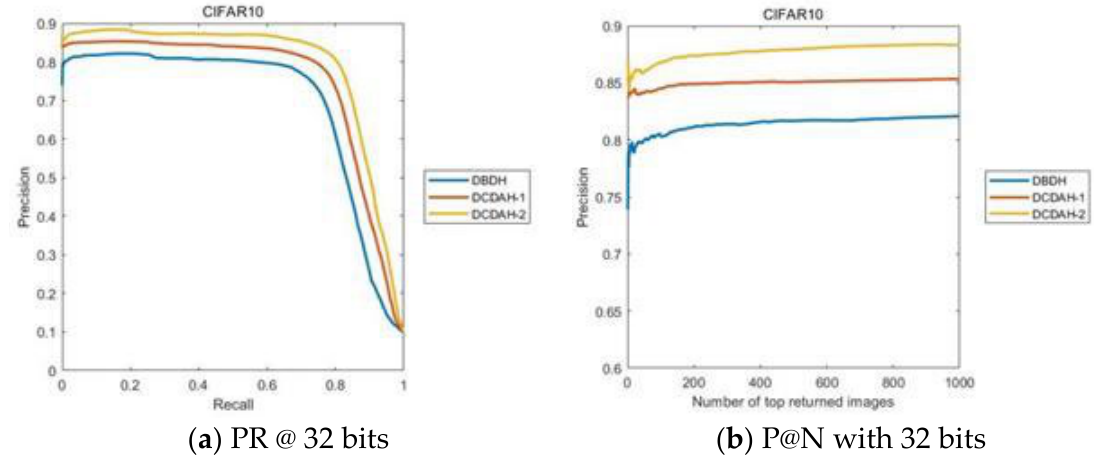
Figure 4. PR and P@N curves on CIFAR-10 when the hash code length is 32 bits.